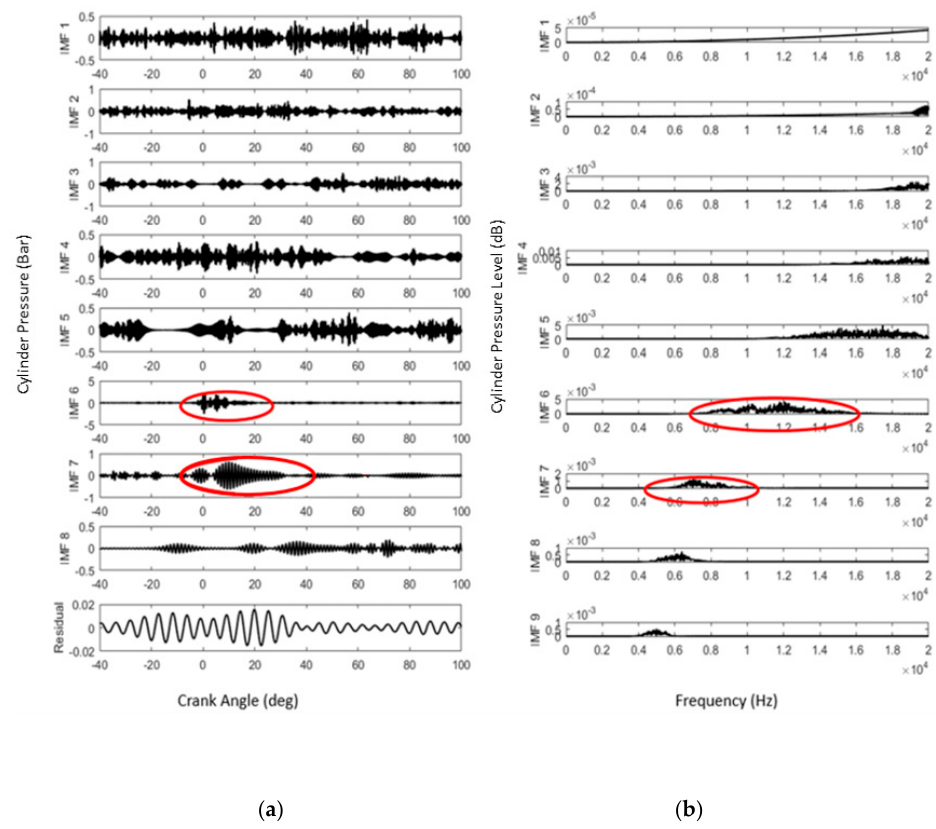
Figure 9. IMFs components of in-cylinder pressure by cyclic average TVF-EMD with 100 cycles: ( a ) in the crank angle domain; ( b ) in the frequency domain.